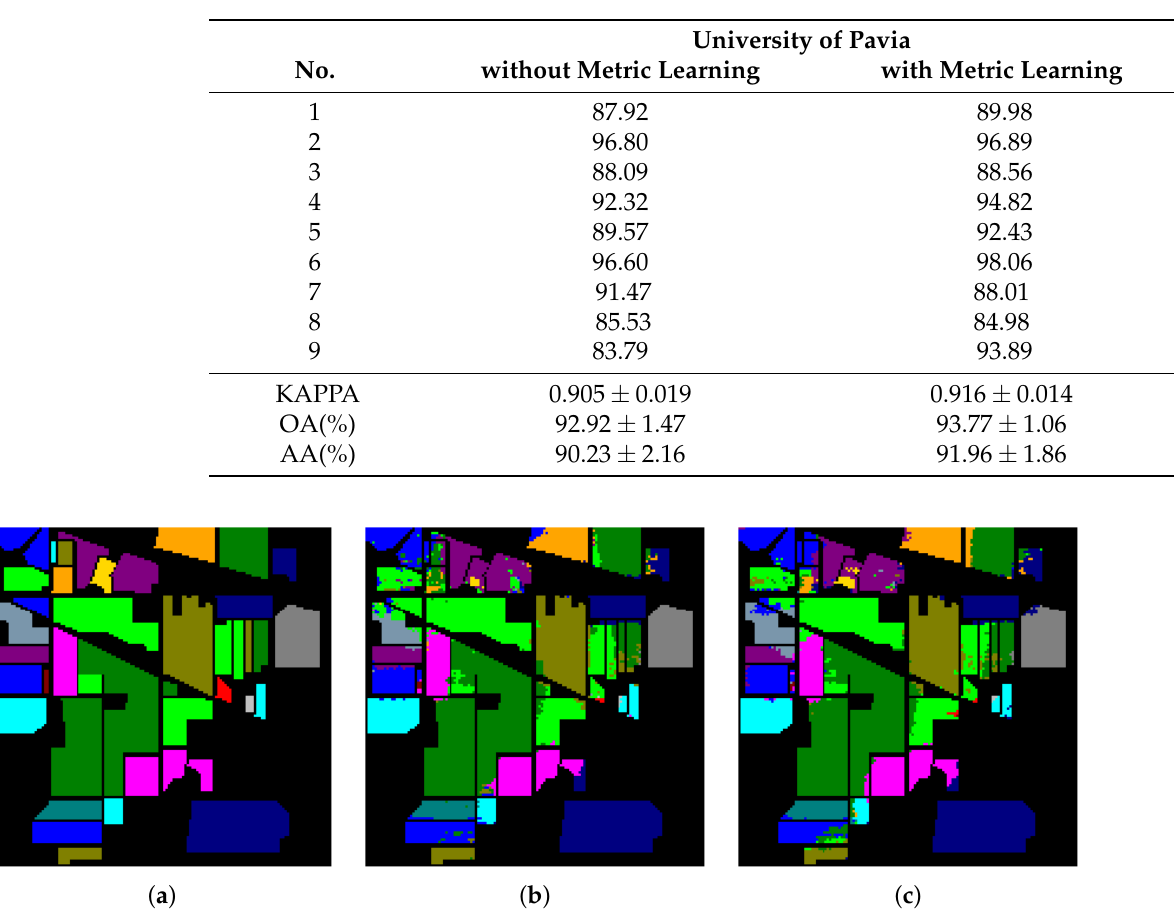
Figure 15. The classification maps of Indian Pines. ( a ) Ground-truth map. ( b ) Classification results of the Transformer without metric learning. ( c ) Classification results of the Transformer with metric learning.